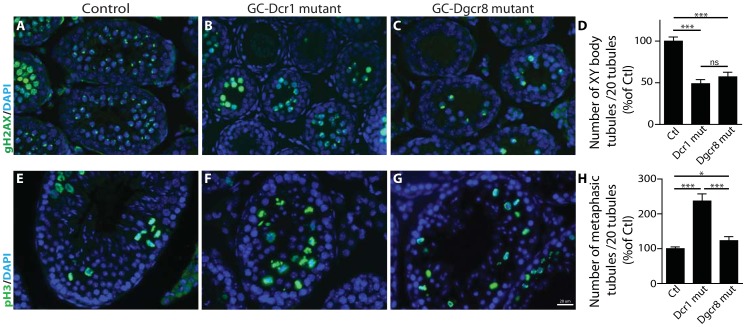
Meiotic defects in GC-Dcr1 and GC-Dgcr8 mutant testes.(A–D) Anti-γH2AX (green), present in the entire nucleus in early meiotic stages and located to the XY body during the pachytene stage, indicates a decreased number of tubules containing XY body positive cells in GC-Dcr1 and GC-Dgcr8 mutant testes compared to controls at P12. (E–H) Anti-pH3 (green), present in metaphasic cells, reveals a reduction in the number of metaphasic tubules within GC-Dcr1 and GC-Dgcr8 mutants in P60 testes compared to controls. DAPI (blue) was used for nuclear staining. Results are mean ± SEM (n = 3/genotype), * = p<0.05, ** = p<0.005, *** = p<0.0001 GC-Dcr1 mutant vs. control, GC-Dgcr8 mutant vs. control or GC-Dcr1 vs. GC-Dgcr8. Scale bars: 20 µm.